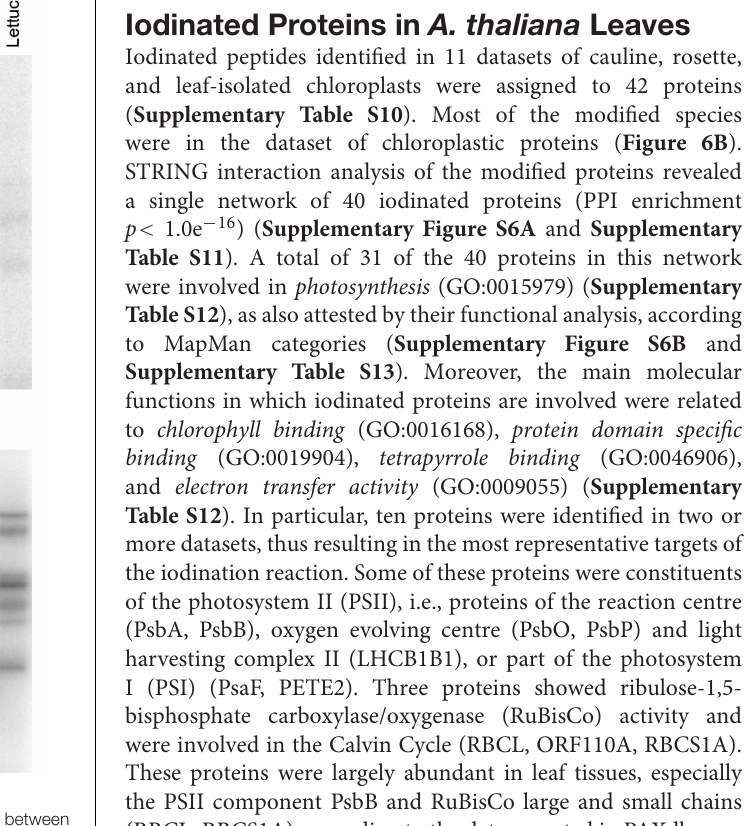
FIGURE 5 | Autoradiographies of the SDS-PAGE gels. Comparison between the position and relative intensities of 125 I radiolabelled bands of representative shoot (A) and root (B) protein extracts from 125 I treated Arabidopsis (exp. 1-radioactive), and maize, tomato, wheat and lettuce plants (exp. 2-radioactive). Sampling was performed after 48 h of 125 I incubation. In both the experiments, autoradiographies were acquired after 72 h of gel exposition to the multipurpose phosphor storage screen. Representative pictures of total stained protein extracts (SDS-PAGE) and of the autoradiographies of control samples after 15 days of exposition are also shown. Controls consisted in protein extracts obtained from plants untreated with 125 I during their growth, to which the radioactive solution containing 125 I was added during the extraction